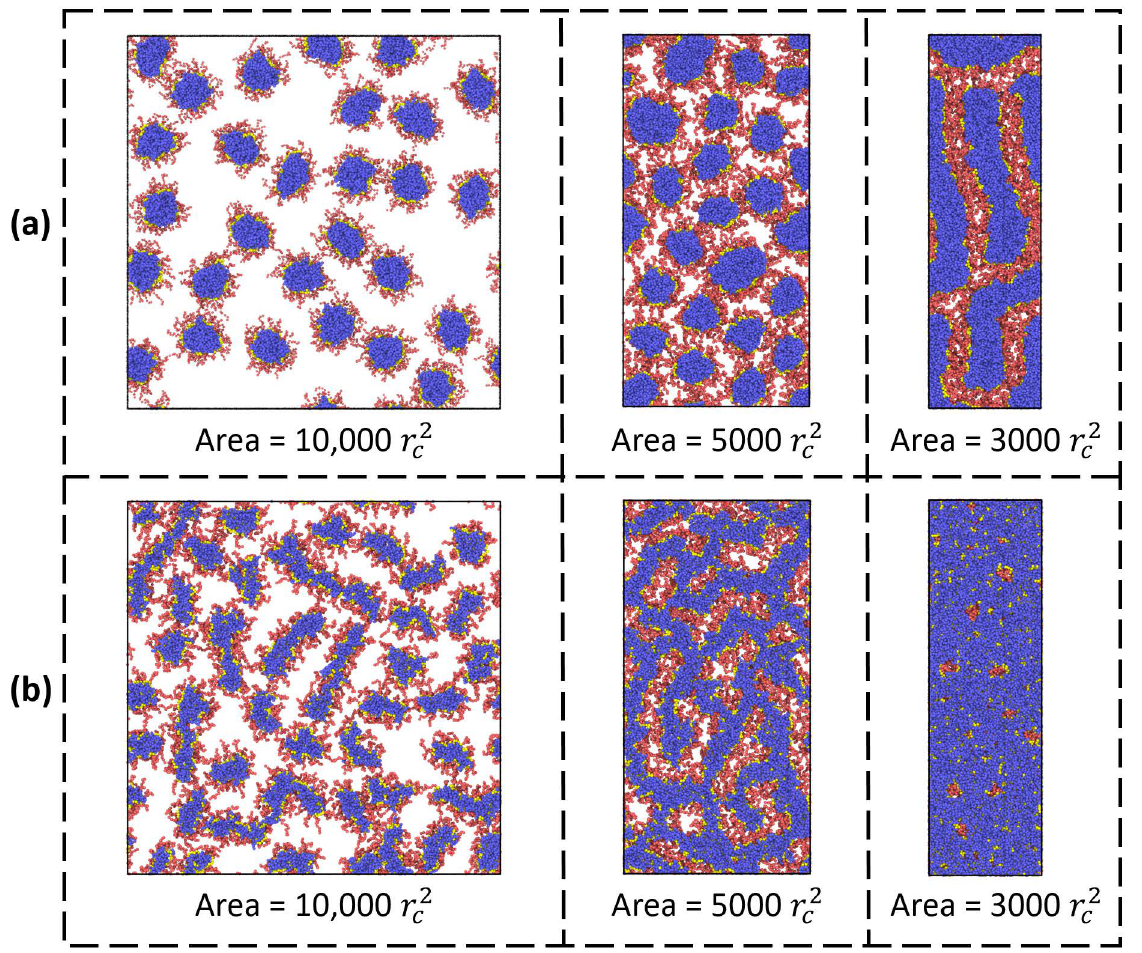
Figure 5. Top views of the liquid interface with adsorbed amphiphilic bottlebrushes at different compression ratios. The interfacial area is compressed from L x × L y = 100 × 100 to 50 × 100 and then to 30 × 100. The bottlebrush architecture parameters are: ( a ) n b = 10, n bb = 100, and f a = 0.5; and ( b ) n b = 3, n bb = 100, and f a = 0.33.